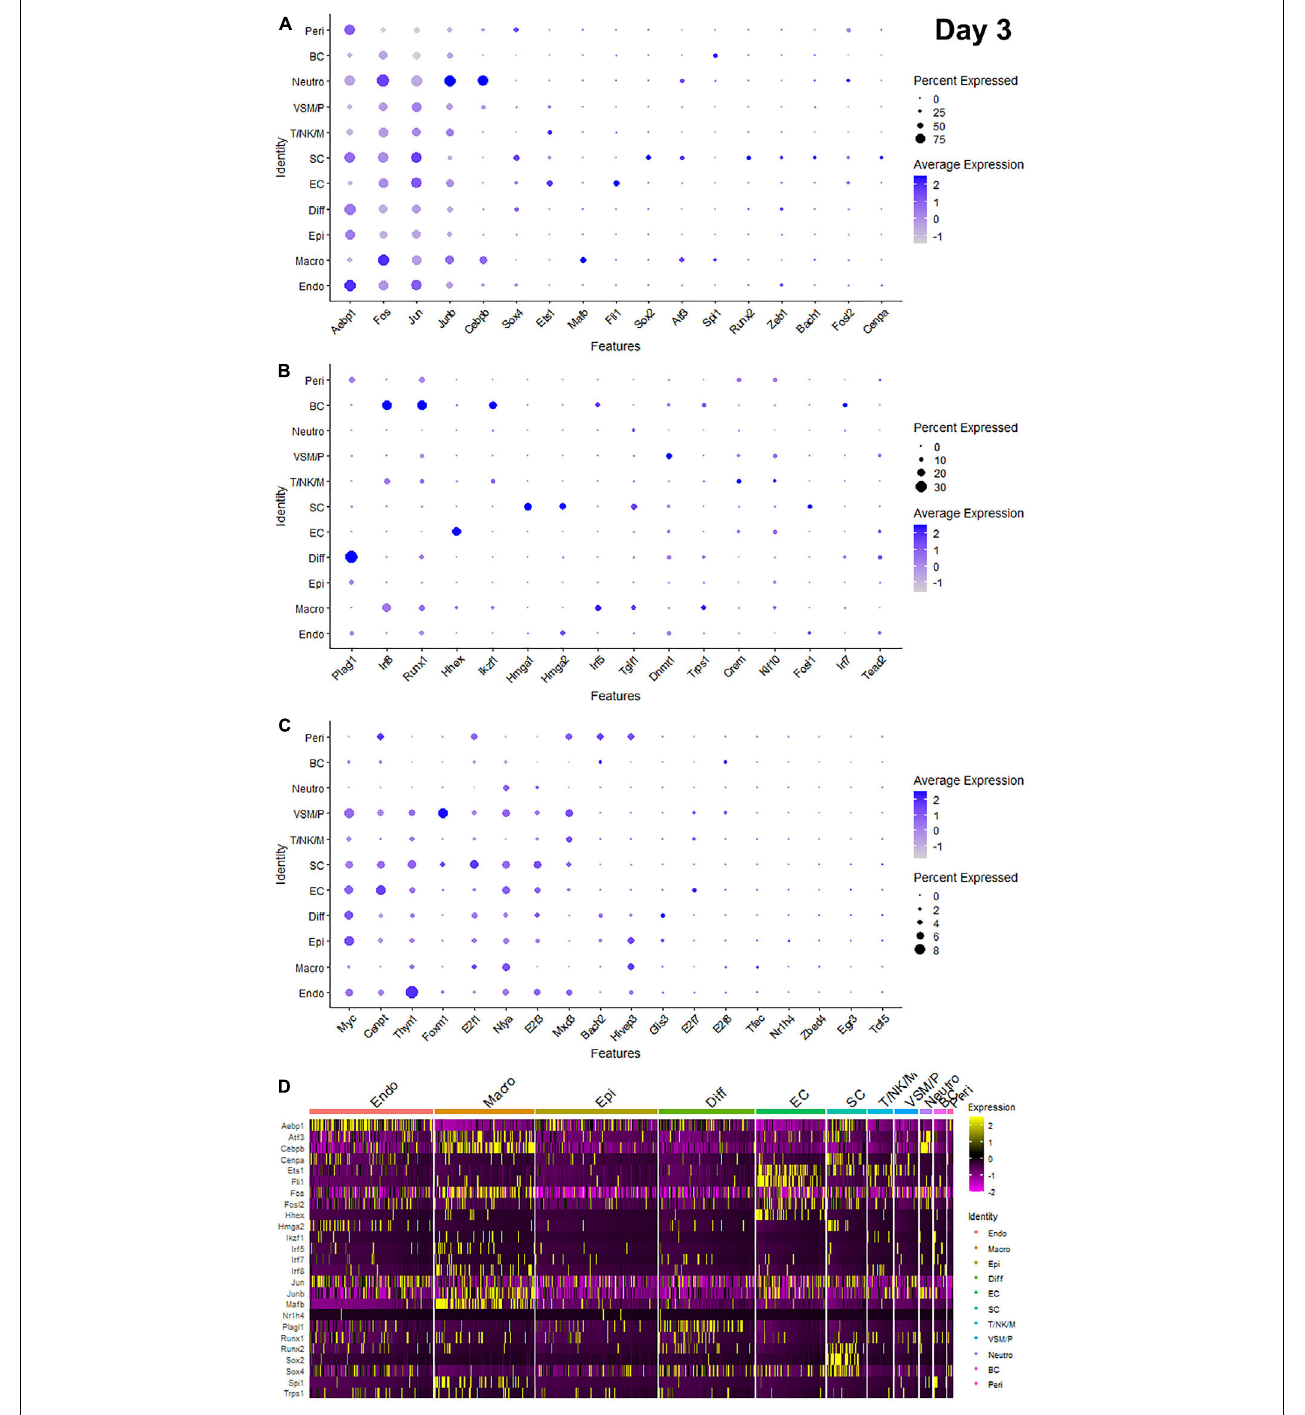
FIGURE 2 | Dotplots and heatmap showing 51 TFs that are up-regulated in the distal nerve at day 3 post-injury. (A) Dotplots for Aebp1, Fos, Jun, Junb, Cebpb, Sox4, Ets1, Mafb, Fli1, Sox2, Atf3, Spi1, Runx2, Zeb1, Bach1, Fosl2, and Cenpa which have more than 25% expression at least in one cell cluster. (B) Dotplots for Plagl1, Irf8, Runx1, Hhex, Ikzf1, Hmga1, Hmga2, Irf5, Tgif1, Dnmt1, Trps1, Crem, Klf10, Fosl1, Irf7, and Tead2 which have expression between 8 and 25% at least in one cell cluster. (C) Dotplots for Myc, Cenpt, Thyn1, Foxm1, E2f1, Nfya, E2f3, Mxd3, Bach2, Hivep3, Glis3, E2f7, E2f8, Tfec, Nr1h4, Zbed4, Egr3, and Tcfl5 which have expression below 8% in any cell cluster. (D) Heatmap for Aebp1, Atf3, Cebpb, Cenpa, Ets1, Fli1, Fos, Fosl2, Hhex, Hmga2, Ikzf1, Irf5, Irf7, Irf8, Jun, Junb, Mafb, Nr1h4, Plagl1, Runx1, Runx2, Sox2, Sox4, Spi1, and Trps1. Diff: Differentiating fibroblasts; Endo: Endoneurial fibroblasts; Peri: Perineurial fibroblasts; Epi: Epineurial fibroblasts; SC: Schwann cells; EC: Endothelial cells; VSM/P: Vascular smooth muscle cells and pericytes; Neutro: Neutrophils; Macro: Macrophages; BC: B cells; T/NK/M: T cells, NK cells, and mast cells.